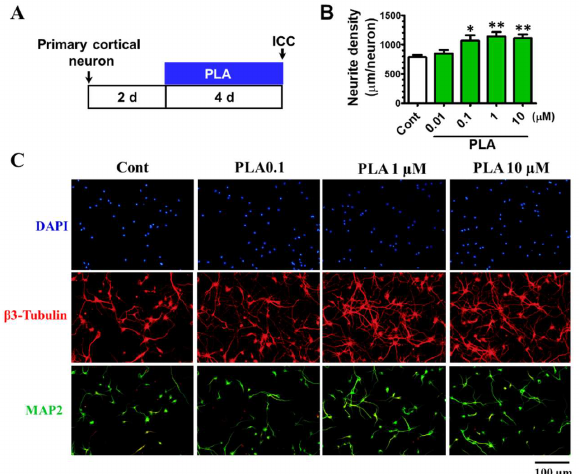
Figure 7. E ff ects of platycodigenin (PLA) on neurite outgrowth. Primary cultured cortical neurons were cultured for 2 d following treated with PLA (0.01–10 µ M) or control (Cont, 0.1% DMSO) for another 4 d. The neurons were fixed and immunostained for β 3-tubulin and MAP2. The lengths of the β 3-tubulin positive neurites were measured. ( A ) Time schedule of the experiments. ( B ) Quantification of total neurite outgrowth and associated statistics. ( C ) Representative images of β 3-tubulin and MAP2 positive neurites. Scale bar, 100 µ m. The data are shown as the mean ± SEM of three independent experiments. Ten images were captured of each group in the independent experiment. * p < 0.05 and ** p < 0.01 versus control (Cont), one-way analysis of variance and Dunnett’s post hoc